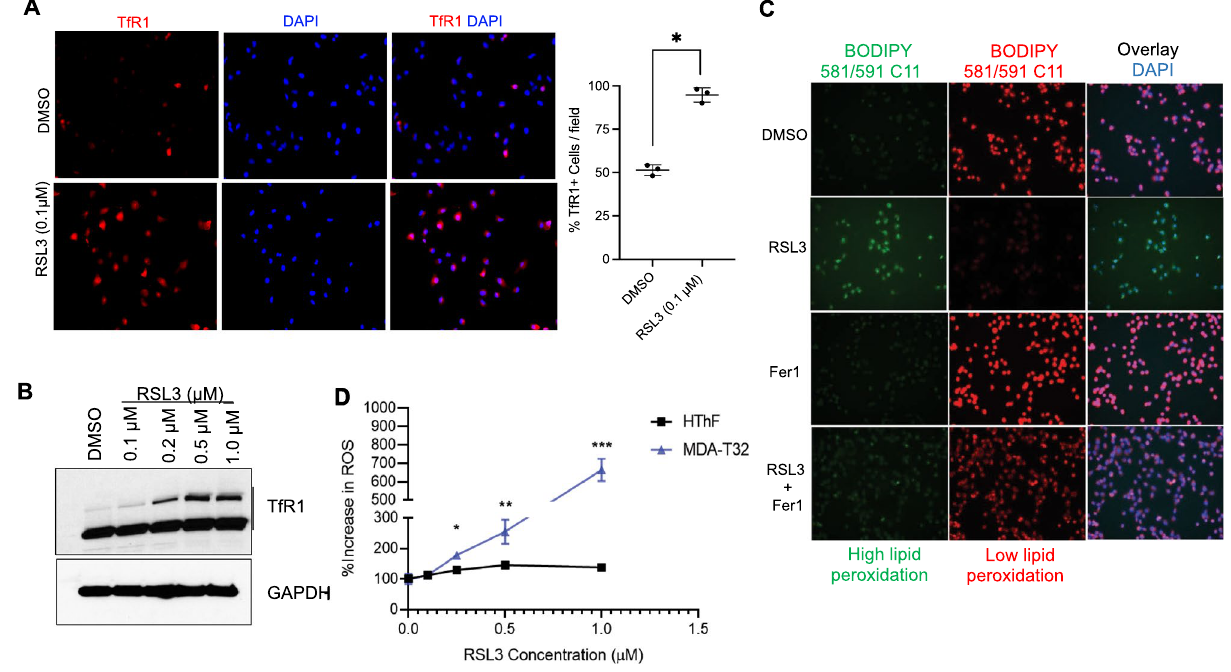
Figure 2. Pharmacologic inhibition of GPX4 with RSL3 induces ferroptosis activation, intracellular lipid peroxidation, and increased reactive oxygen species (ROS) in PTC in vitro. ( A ) Immunofluorescent staining for TfR1 in K1 cells treated with DMSO control or RSL3 (0.1 μM) for 6 h showed increased TfR1 expression relative to control-cells (94.7% vs 57.3%; p = 0.003; TfR1 = red, DAPI = blue, 20 × magnification). ( B ) RSL3 induced increased TfR1 protein expression after 4 h treatment in dose-dependent manner. ( C ) Staining of K1 cells with BODIPY 581/591 C11 lipid peroxidation dye, a ferroptosis marker, in RSL3 (3 μM; 4 h) and ferrostatin-1 (Fer1, 5 μM)-treated cells. ( D ) Induction of intracellular reactive oxygen species (ROS) by RSL3 treatment (24 h) in MDA-T32 cancer cells and control HThF cells (* p < 0.05, ** p < 0.01, *** p <